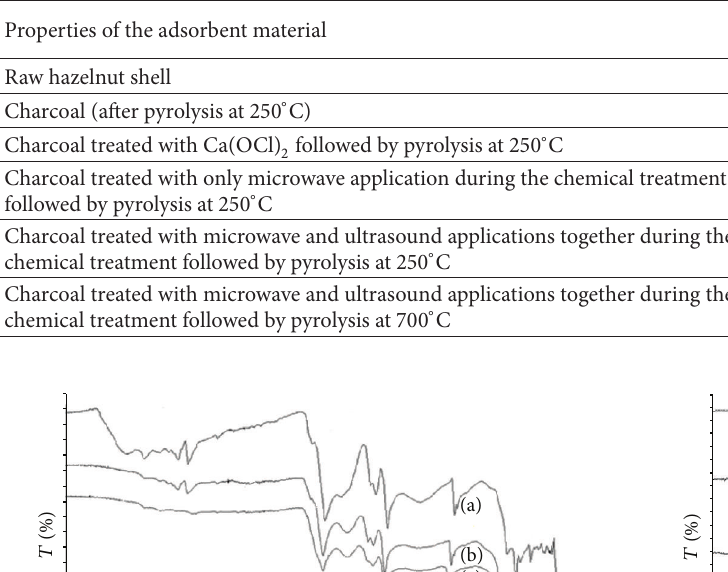
Table 4: Effects of the treatment procedures on the Pb(II) adsorption capacity and surface area of the ACs.